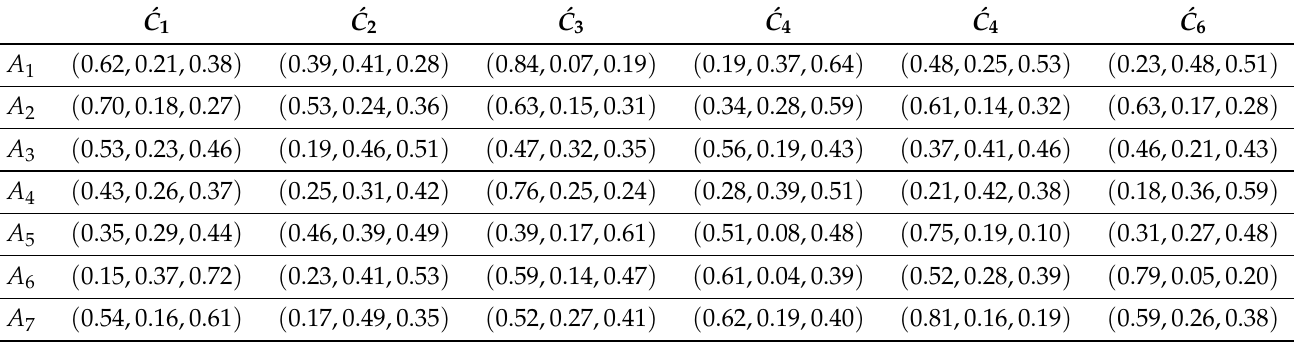
Table 14. Decision matrix D 3 .